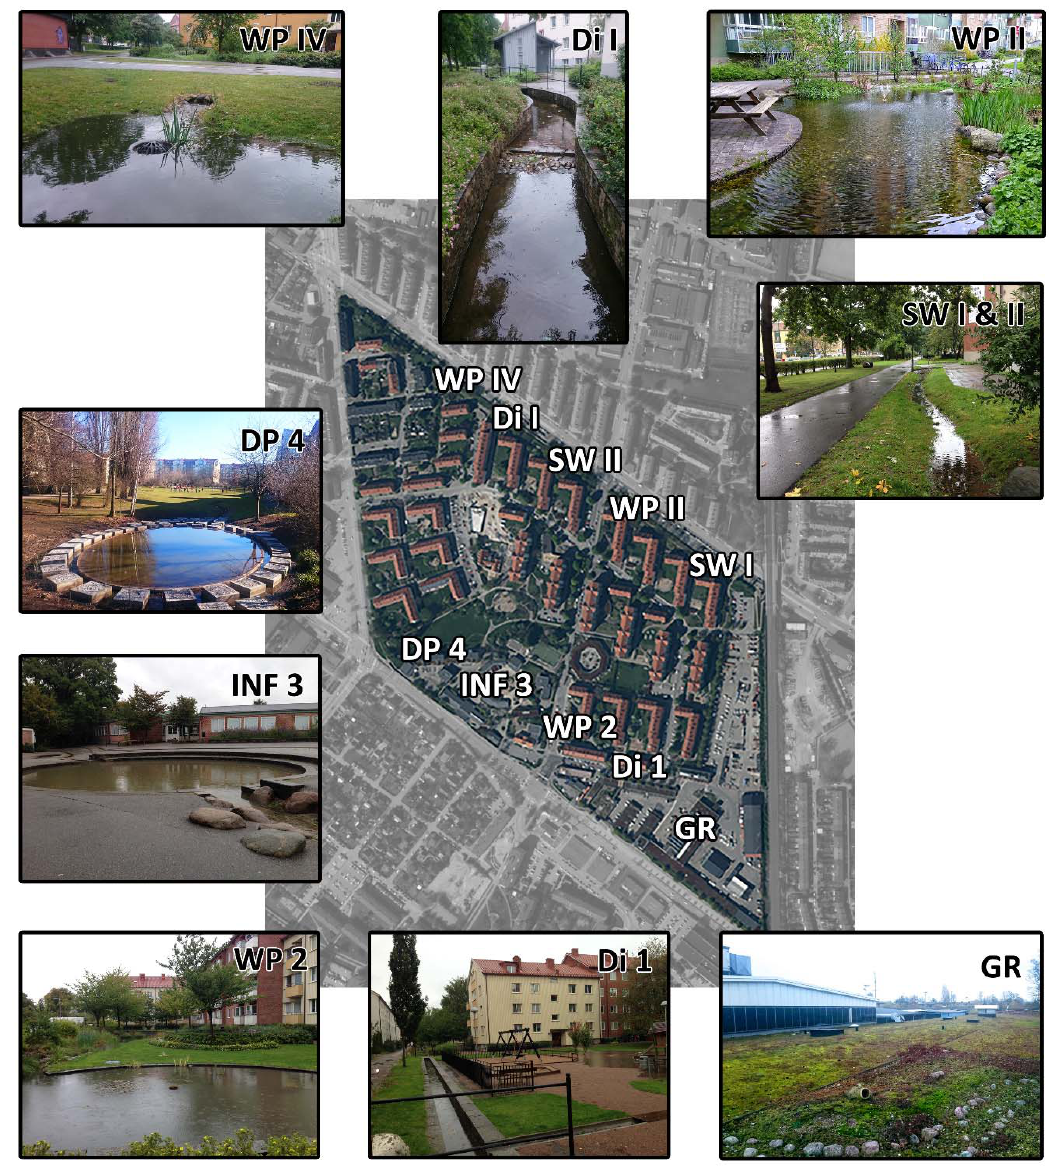
Figure A1. The photos of some of the implemented SCMs in Augustenborg. Different types of SCMs are shown in the figure as follows: ( DP 4 ) dry pond, ( Di I & 1 ) stormwater ditch, ( SW I & II ) swale, ( WP 2, II & IV ) wet pond, ( INF 3 ) infiltration basin, ( GR ) green roof. The major runoff directions in the Northern and Southern systems are SW I → WP IV and GR → DP 4, respectively. Pictures for INF 3, WP 2, Di 1, and SW I & II are taken by Henrik Thorén (Rambøll ) . Background picture: GSD- Orthophoto, courtesy of The Swedish Mapping, Cadastral and Land Registration Authority, © Lantmäteriet (2015).